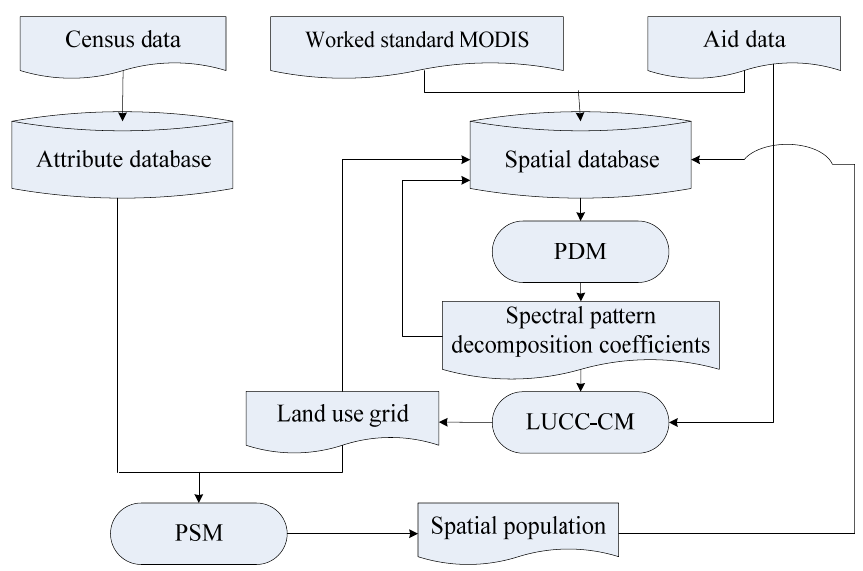
Figure 2. Data process flow of